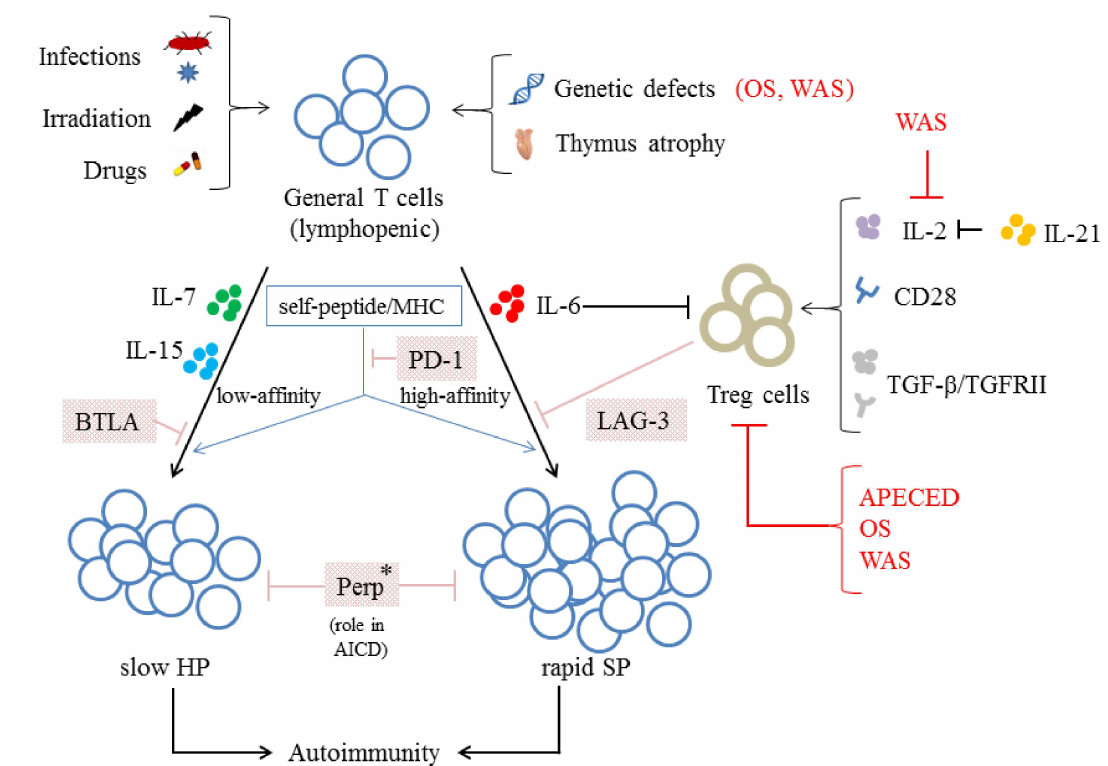
Figure 2. The induction, types and regulation mechanisms of LIP. Several triggers have been shown to induce lymphopenia including infection, irradiation, drugs, genetic defects, and thymus atrophy. LIP could occur via two pathways: slow homeostatic proliferation (HP) and rapid spontaneous proliferation (SP). HP is mediated by cytokines (IL-7 and/or IL-15) and interaction with self-peptide/MHC with low affinity. On the other hand, SP is regulated by cytokine IL-6 and interaction with self-peptide/MHC with high affinity. Treg cells might inhibit SP through LAG-3. Treg cells could be regulated by the presence of CD28, IL-2 production, and the TGF- β /TGFRII pathway; IL-21 could counteract Tregs function by inhibiting IL-2 production. IL-6 inhibits Treg cell function and expansion. PD-1 inhibits the LIP of T cells through its effect on peptide/MHC-II. BTLA negatively regulates the HP. Perp inhibits the persistence of T cells undergoing LIP through its role in activation-induced cell death; it is not known whether it exhibits a general role in both forms of LIP or in a certain form of LIP ( ∗ ). The roles of PIDs in the pathways of LIP are indicated in red. Arrows and T-bars indicate positive and negative effects,